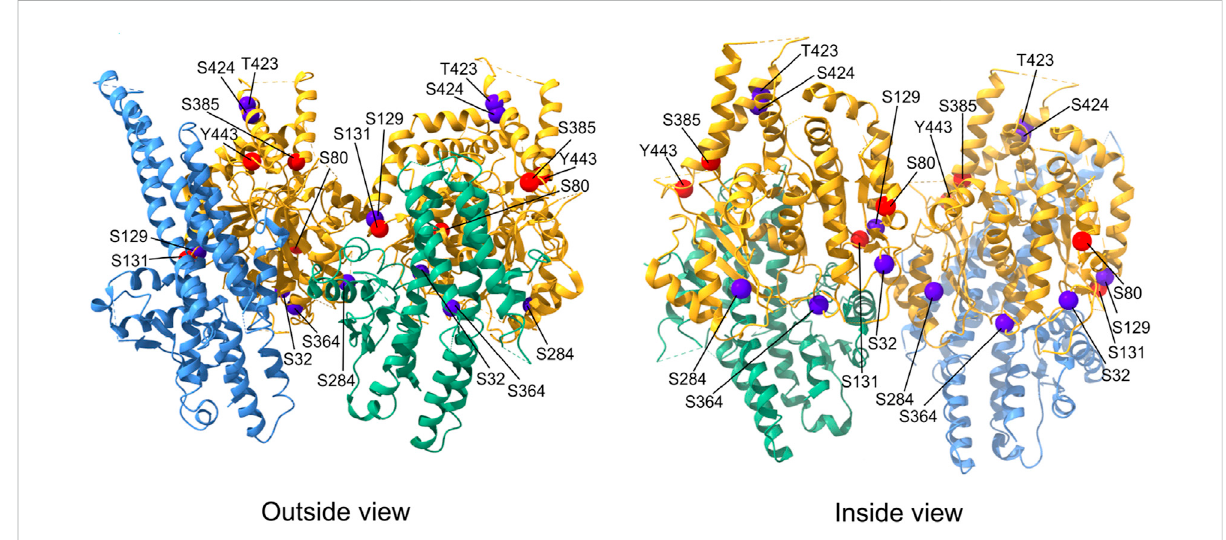
FIGURE 1 Distribution of phosphorylation sites on human γ -tubulin. Exterior and interior views of the γ -TuSC portion containing γ -tubulins (yellow) interacting with the C-terminal GRIP2 domains of GCP2 (green) and GCP3 (light blue). The position of γ -tubulin phosphorylation sites for which kinases are known are marked with red spheres, phosphorylation sites without corresponding kinases are marked with dark blue spheres. The molecular structure representation is based on native human γ -TuRC (PDB: 6v6s) and was generated using ChimeraX 1.3